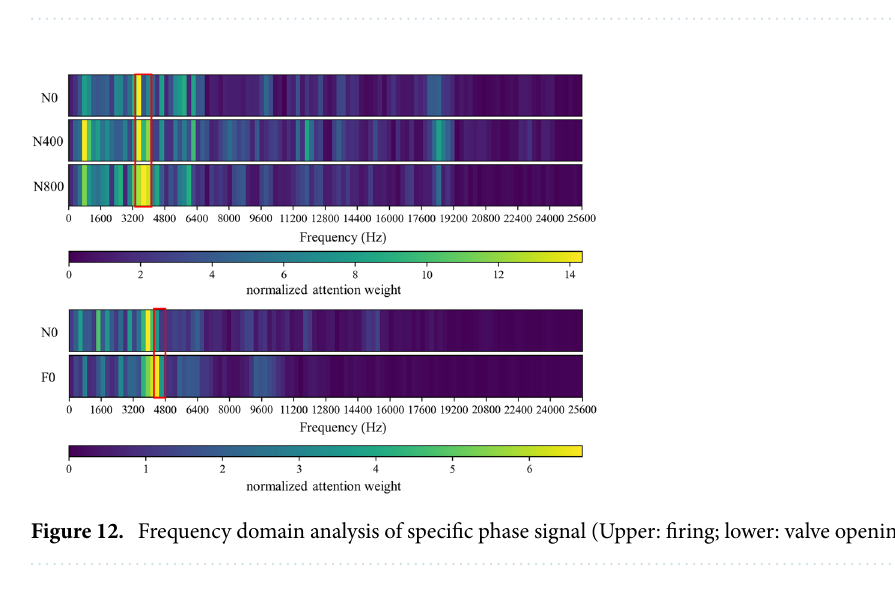
Figure 11. Attention for each working condition on the frequency domain.